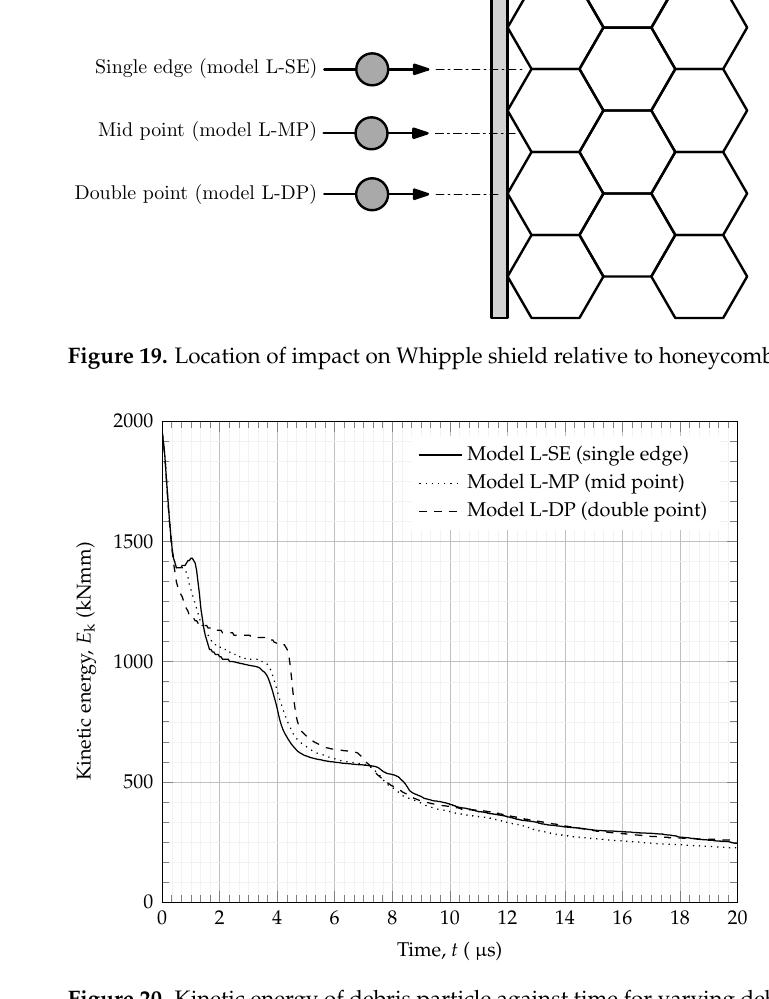
Figure 20. Kinetic energy of debris particle against time for varying debris impact